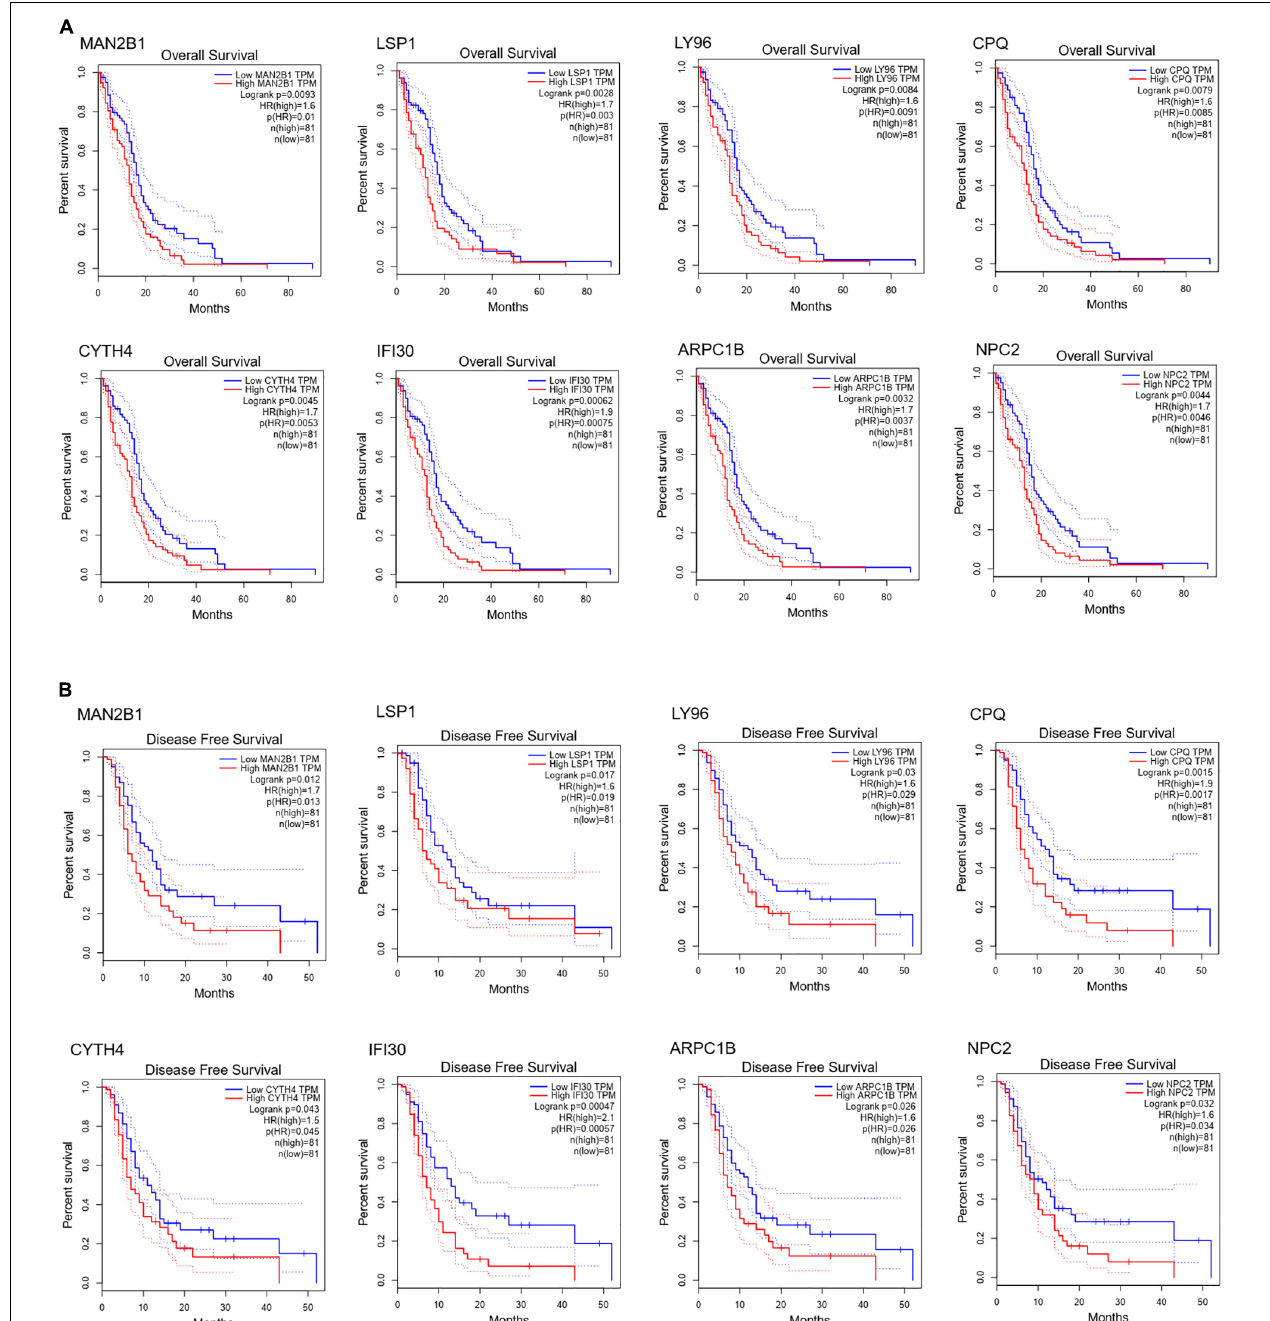
FIGURE 4 | Survival curves of OS (A) and DFS (B) of eight common DEGs. Survival curves of OS (A) and DFS (B) of MAN2B1; LSP1; LY96; CPQ; CYTH4; IFI30; ARPC1B; NPC2 in normal and GBM tissues based on TCGA data in GEPIA. Red line indicates the samples with gene highly expressed, and blue line shows the samples with gene lowly expressed. HR, hazard